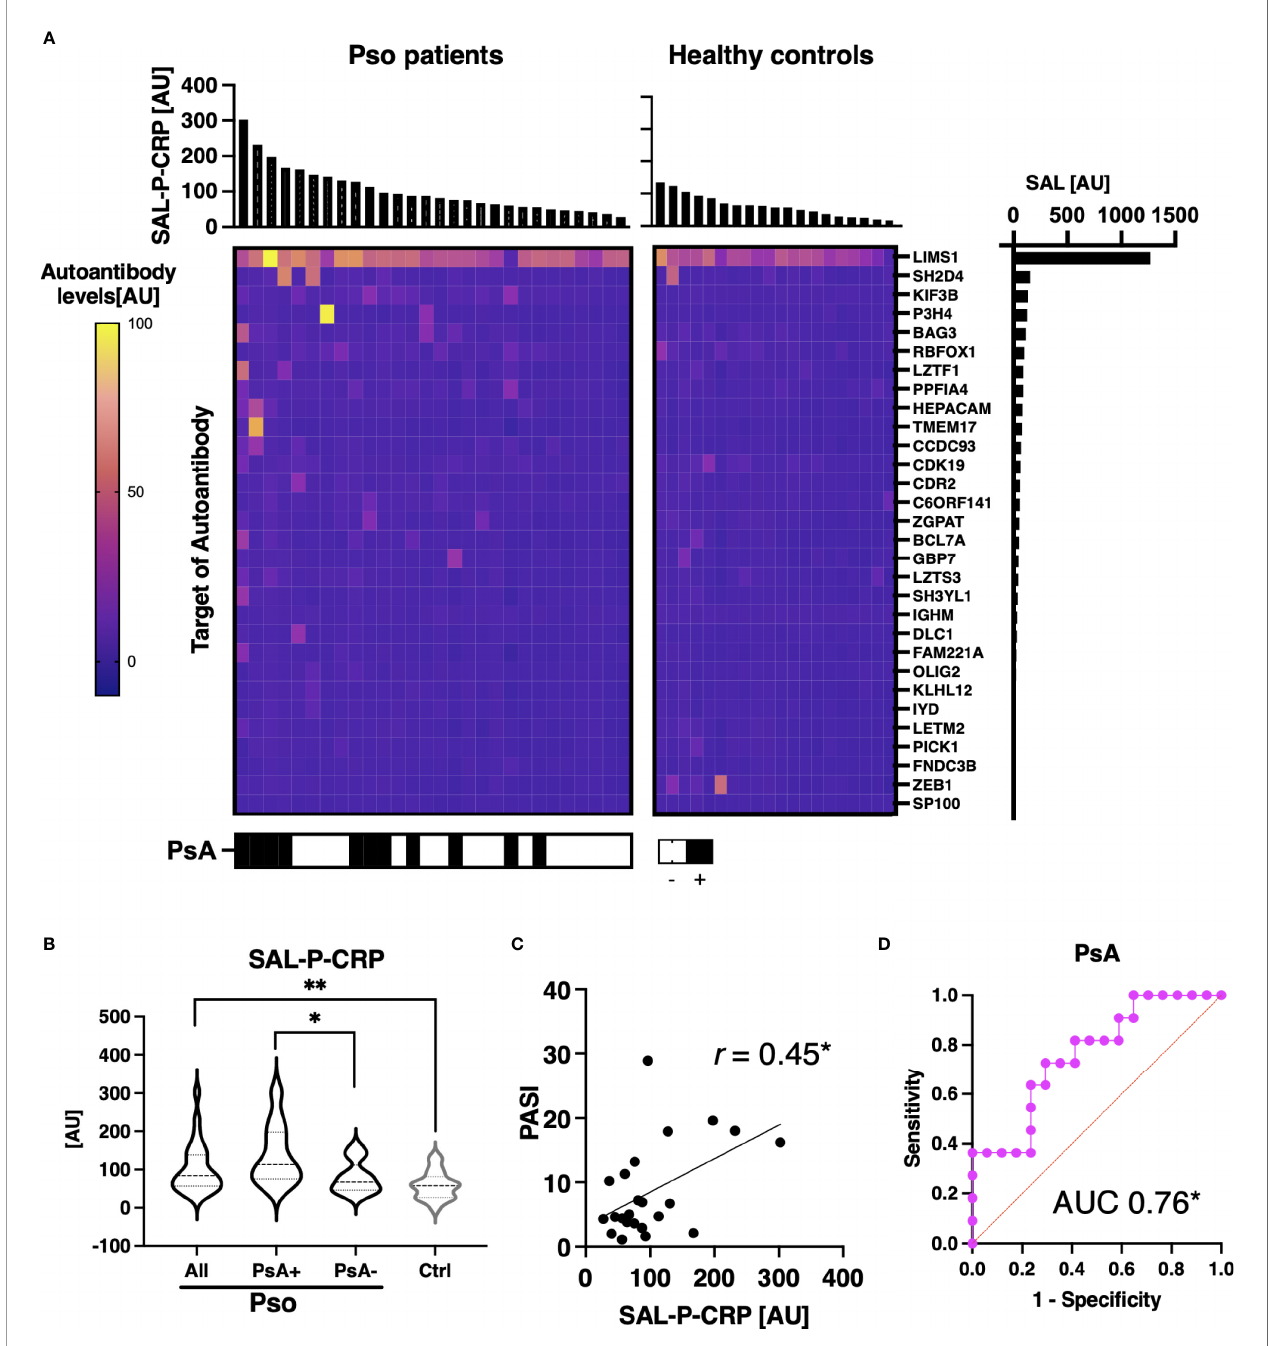
FIGURE 6 | Association between sum of autoantibody levels and clinical presentation in psoriasis patients. (A) Heatmap of 30 autoantibodies that positively correlate with serum levels of CRP with statistical signi fi cance in individual sera of psoriasis (Pso). The targets of autoantibodies are described with the gene symbols of their origin. SAL-P-CRP: sum of autoantibody levels that positively correlated with serum C-reactive protein (CRP) levels. AU: arbitrary unit. (B) Violin plots of SAL- P-CRP in Pso patients and healthy controls. Subpopulation analysis revealed that SAL-P-CRP was signi fi cantly elevated among patients with psoriatic arthritis (PsA) compared to the others. P values were calculated by Mann-Whitney U test. (C) Correlation between SAL-P-CRP and psoriasis area and severity index (PASI) score, or serum CRP levels. r: Spearman ’ s correlation coef fi cient. P values were calculated by estimating r . (D) Receiver-operator characteristics curve of accuracy predicting PsA. Area under the curve (AUC) was 0.76 (95% con fi dence interval: 0.58-0.94). * P < 0.05, ** P <